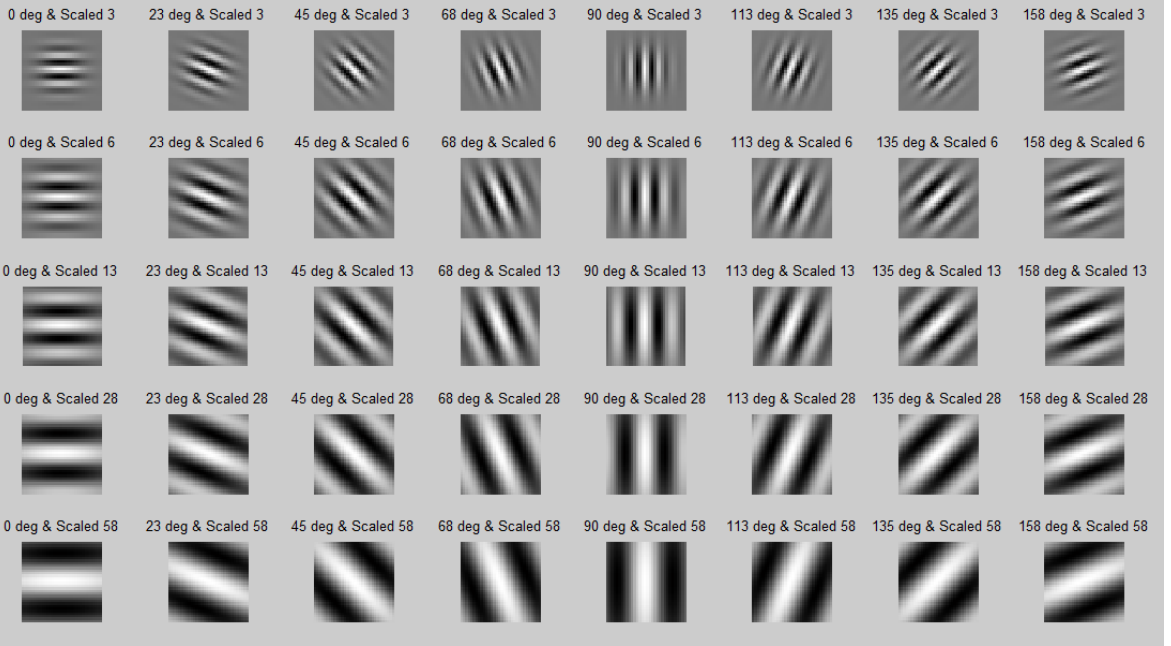
Figure 4. Proposed method Flowchart.